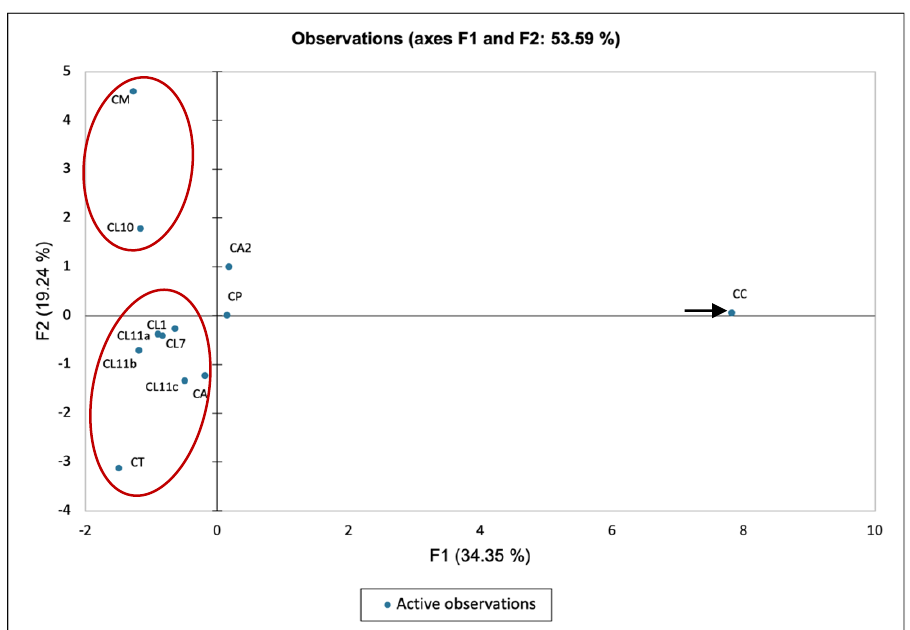
Figure 4. Principal component analysis ordination of 12 oil samples (observations). Axes (F1 and F2 correspond to the first and second principal component responsible. Axis F1 accounts for ca. 34.35% and axis F2 for a further 19.24% of the total variance.